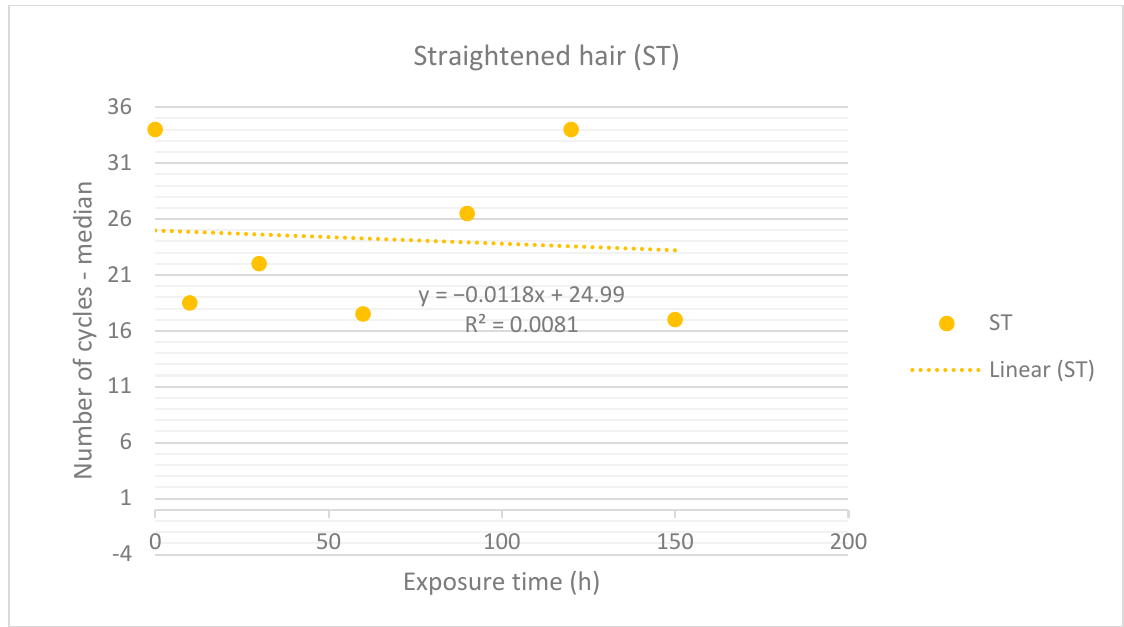
Figure 5. Linear regression of the data obtained for the straightened hair group.